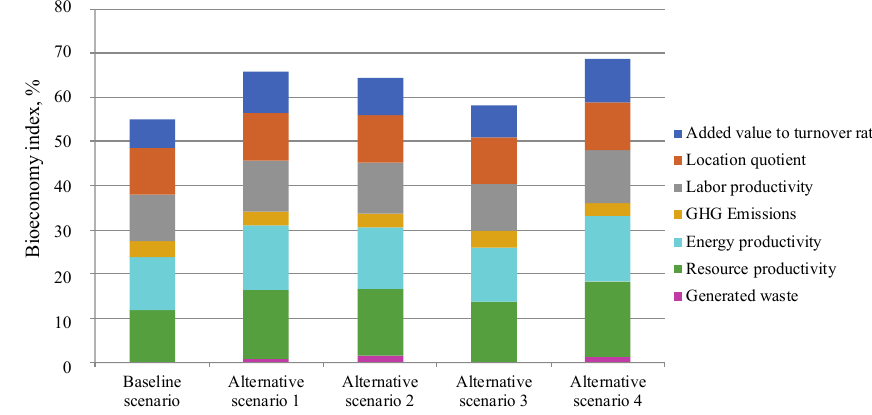
Fig. 8. Bioeconomy index for simulated scenarios at 2030 by indicator